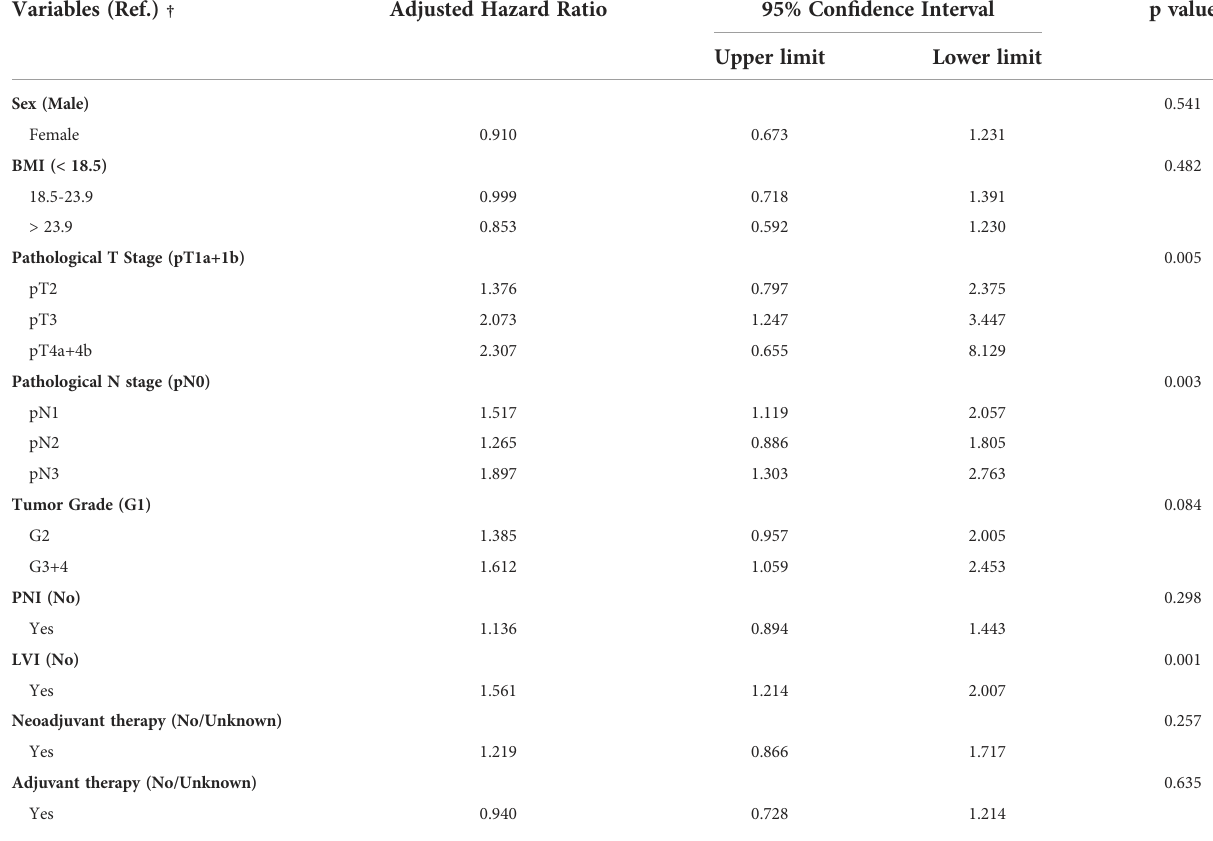
TABLE 2 Multivariate Cox regression analysis for overall survival in patients with resected esophageal squamous cell carcinoma. Variables (Ref.)